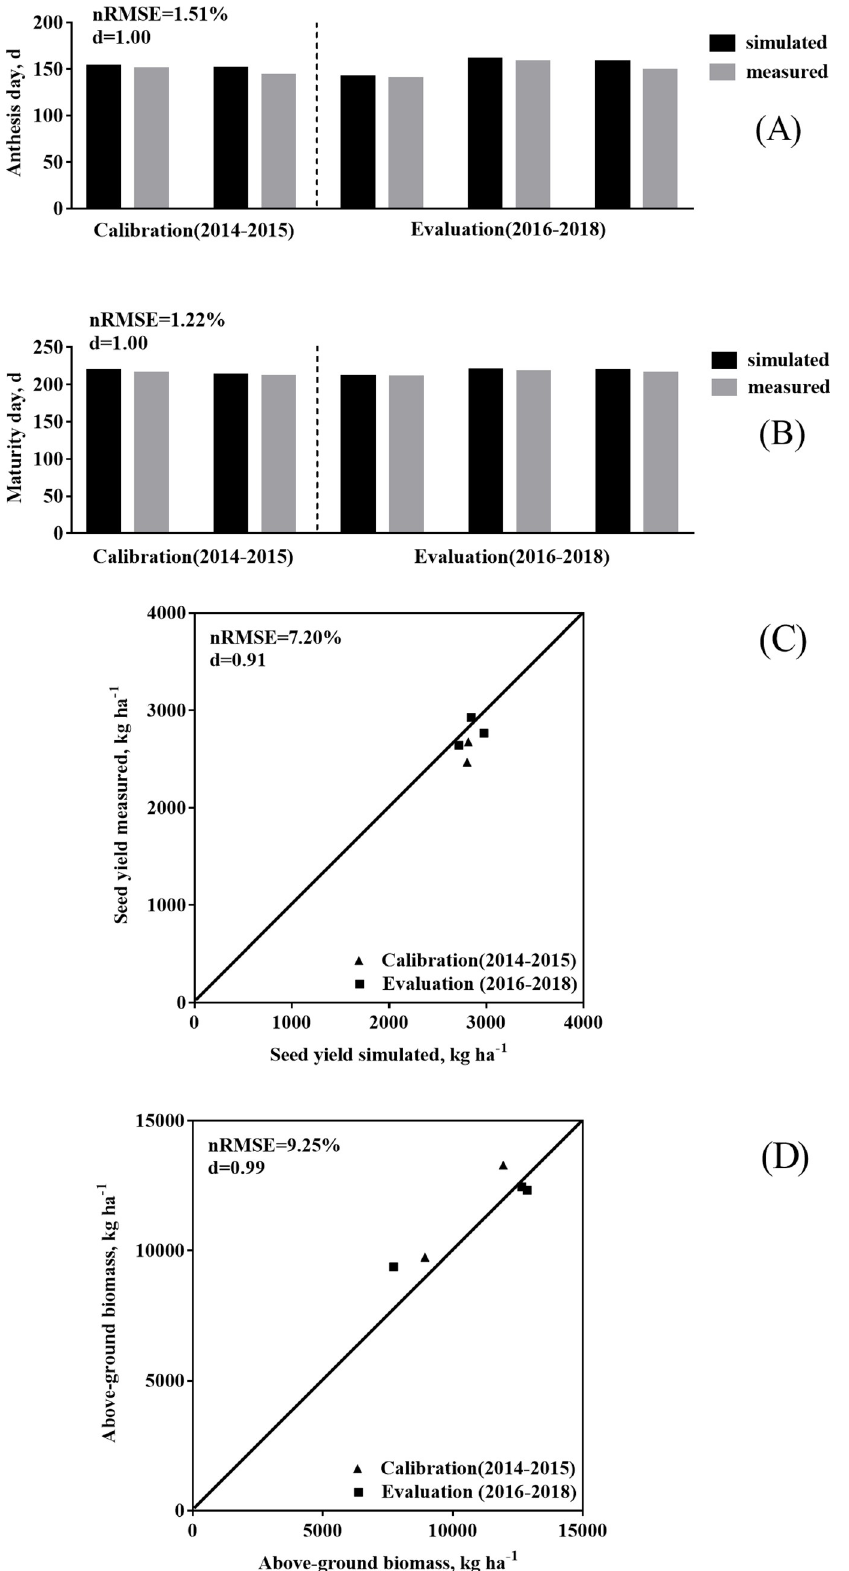
Fig 5. Results of calibration and evaluation for phenology (A) (B), yield (C) and above-ground biomass (D). https://doi.org/10.1371/journal.pone.0259929.g005 PLOS ONE | https://doi.org/10.1371/journal.pone.0259929 November18,